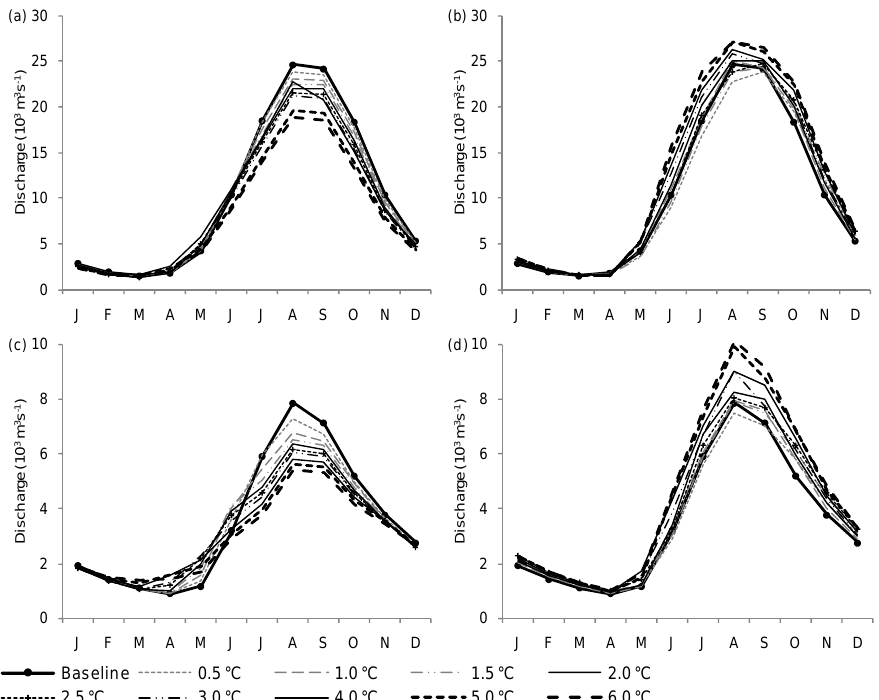
Fig. 4. HadCM3 climate change signal for 0.5–6 ◦ C increases in global mean temperature for the Mekong at Pakse (Mekong 2): (a) temper- ature only, (b) precipitation only; and Lancang at Chiang-Saen: (c) temperature only, (d) precipitation